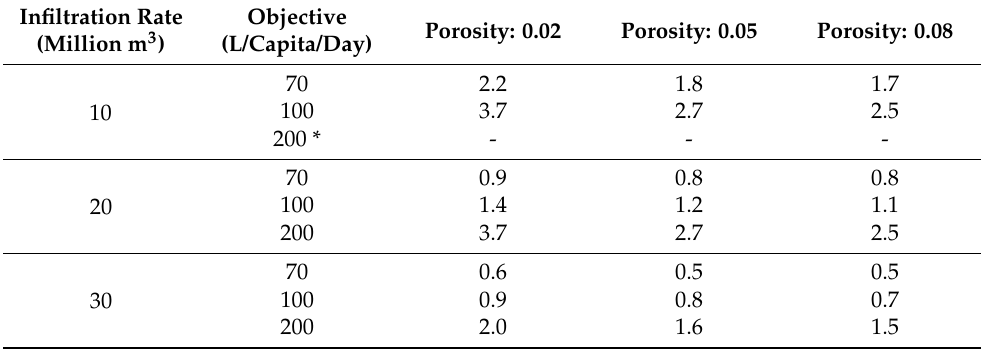
Table 3. Time (year) needed to reach the required amount of water storage (* objective not reached within 5 years).